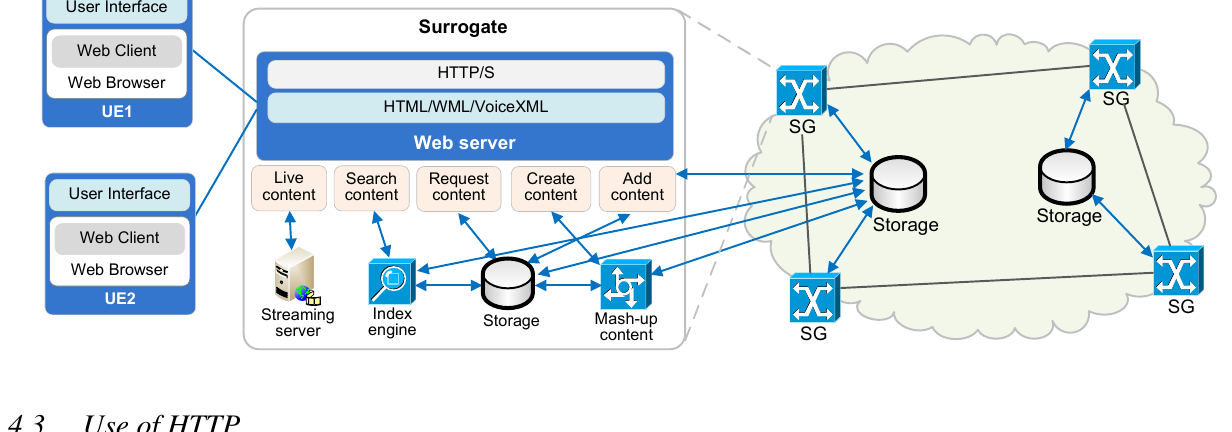
Figure 4. User content manipulation architecture using